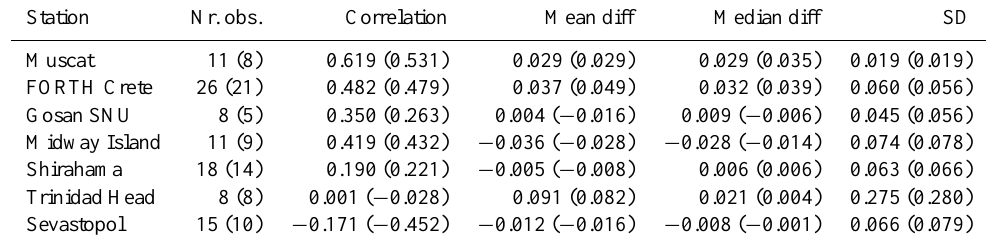
Table 4. The statistics for the SSA comparison (at 670nm) at different AERONET stations for the goodness-of-fit + filtering and, between parentheses, the loose cloud mask filtering. The PARASOL retrievals are additionally filtered on the value of the averaging kernel of the fine mode imaginary refractive index ≥ 0.1 to ensure adequate sensitivity to the absorption.